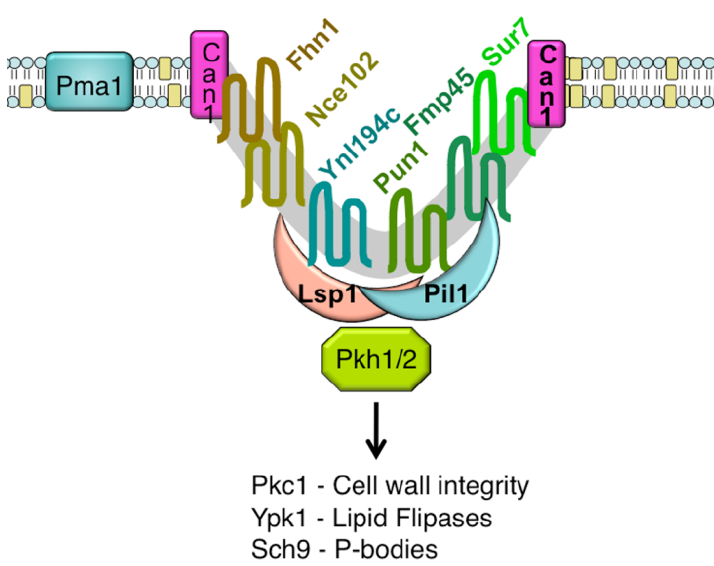
Figure 2. Model for MCC/eisosome